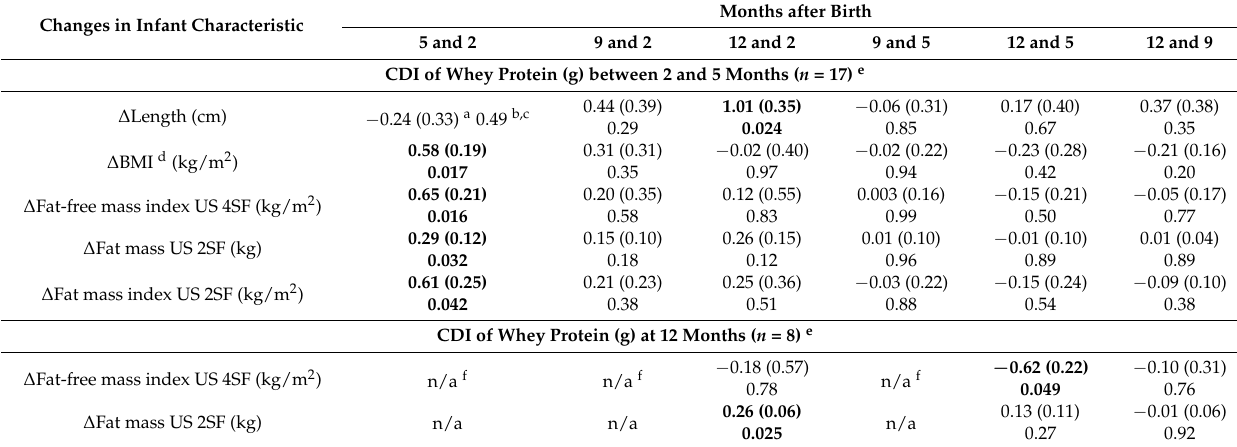
Table A7. Associations between calculated daily intakes of total human milk whey protein at given time points and changes in infant body composition between the time